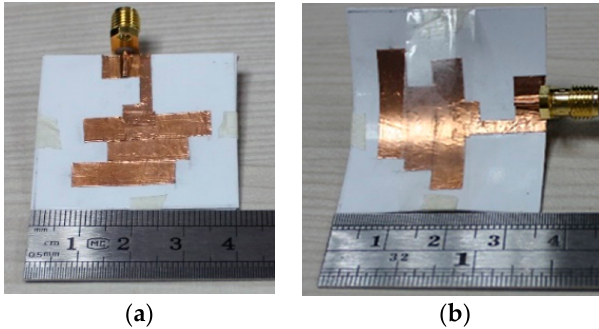
Figure 5. Fabricated antenna prototype in the ( a ) normal condition; ( b ) bent condition.